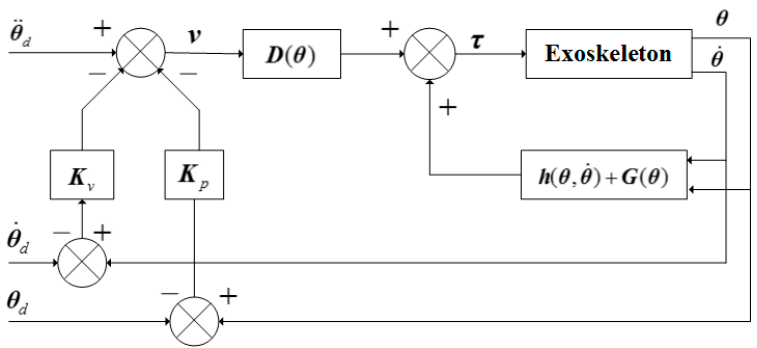
Figure 6. The passive control block diagram.